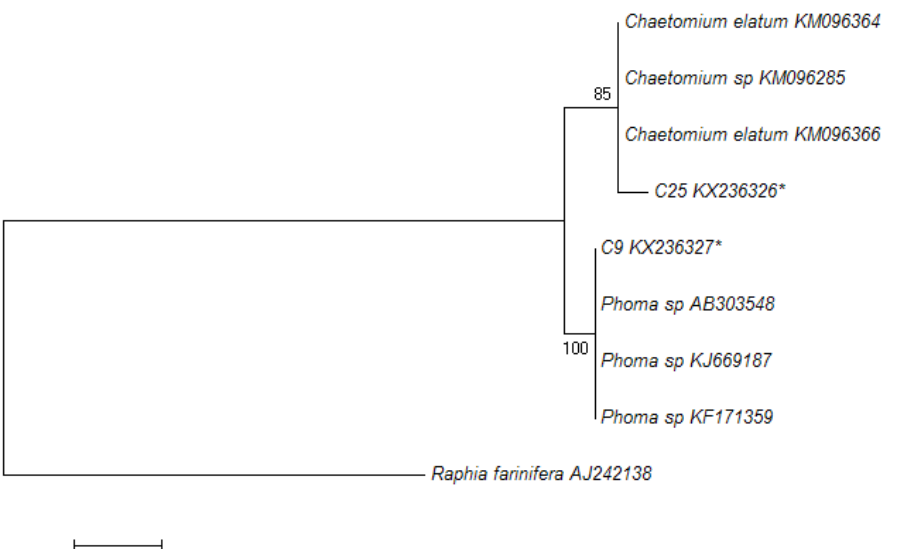
Figure 2: Phylogenetic tree based on the maximum likelihood method from the strains amplified by the primers UN-SSU-817/NS4. * Strains isolated in this study. Bootstrap values are expressed as